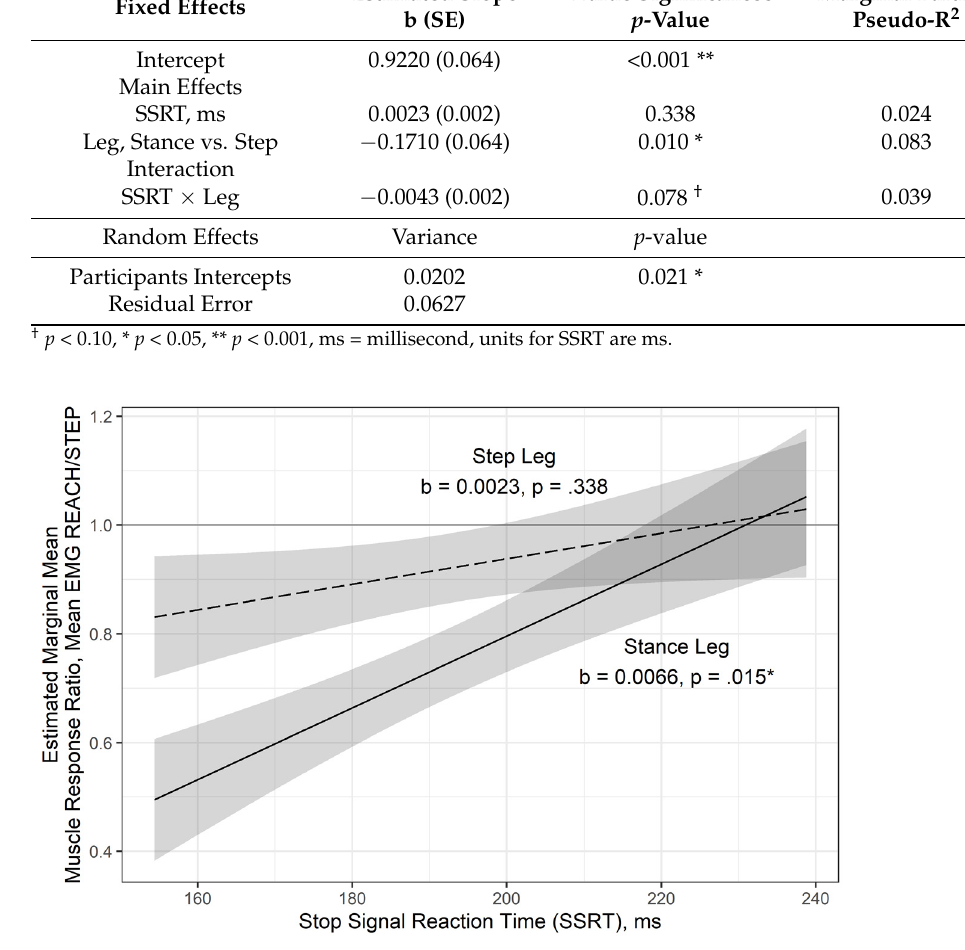
Figure 3. The multilevel model (MLM) and simple slopes analysis identified a relationship between the SSRT and muscle response ratio for the step and stance legs without undue aggregation (ecological fallacy) or risk of type I error rate inflation (multiple comparisons). This model displays strong evidence of a significant association between the SSRT and muscle response ratio (i.e., tendency to suppress a leg response) in the stance leg, but not step leg, irrespective of post-visual preview delay. Confidence bands display plus-or-minus one standard error for the mean (SEM) and the simple slopes (b’s) are provided. * p < 0.05 Table 1. Parameter Estimates of a Two-Level Random Intercepts Multilevel Model (MLM-RI) for muscle response ratio (Mean EMG 300ms Reach/Step), where leg (stance or step) moderates the asso- ciation with the Stop Signal Reaction Time (SSRT, grand mean centered at 193.2 ms). Notes: This single MLM utilized six aggregated muscle response ratios per unique combination of the two legs (stance and step) and three post-visual preview delays (200 ms, 400 ms, 600 ms) per participant: n t